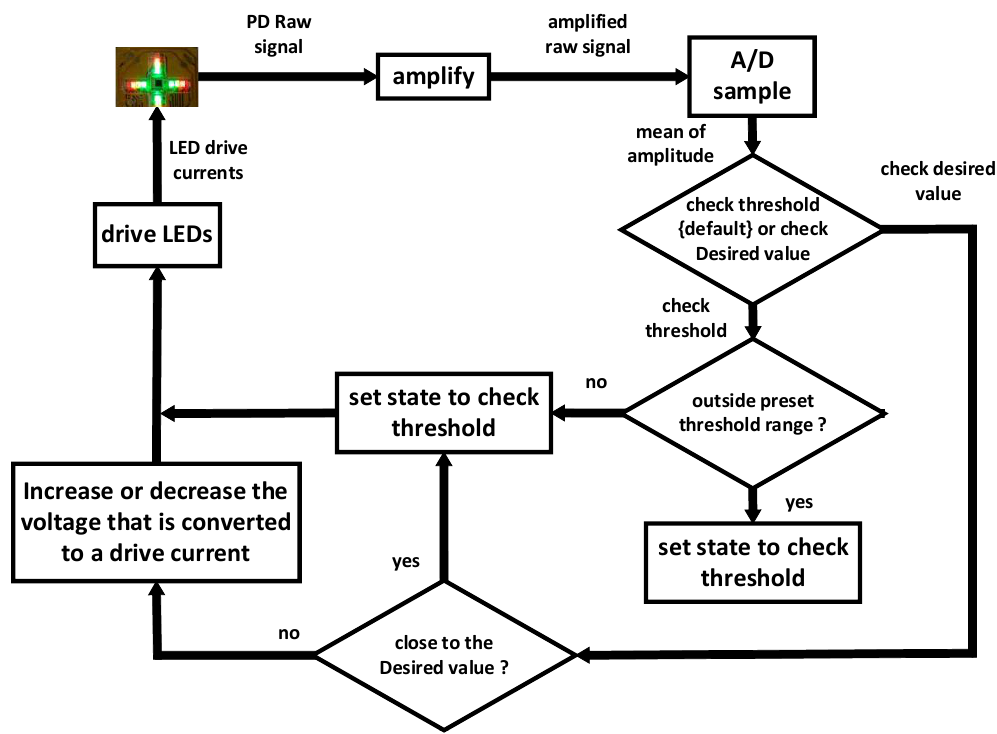
Figure 6. For acquiring high-quality PD signals, the two states of AAOV algorithm are shown in this figure: (1) check the threshold state and determine whether the current intensity of LED needs to be adjusted; and (2) check the desired value state and adjust the LED current to the desire value to obtain an appropriate original signal from PD.